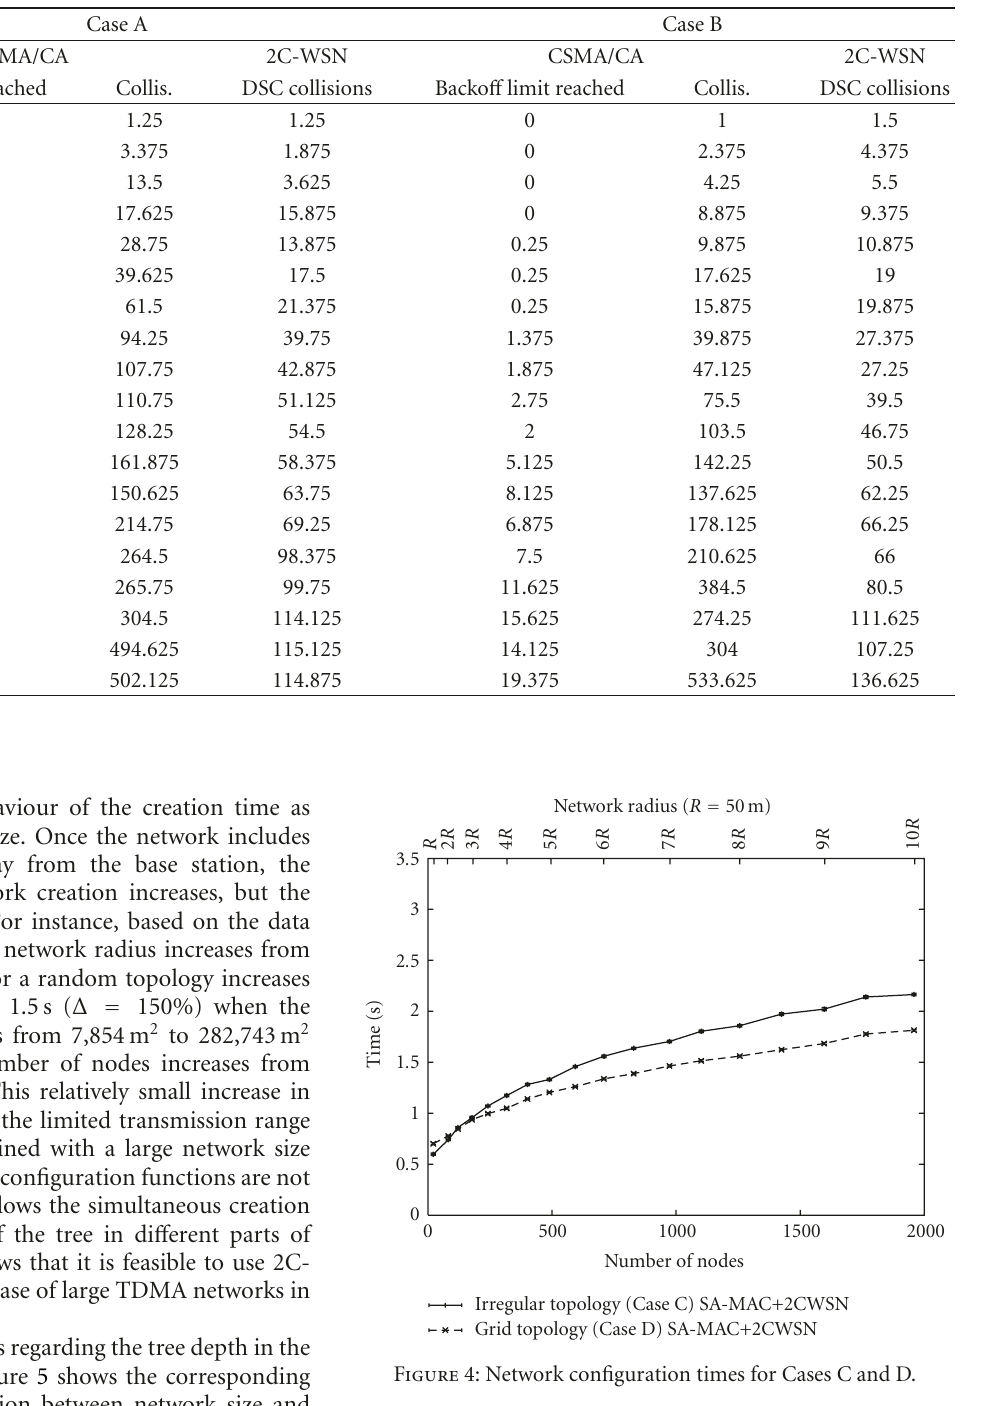
Table 2: Collision-related results.